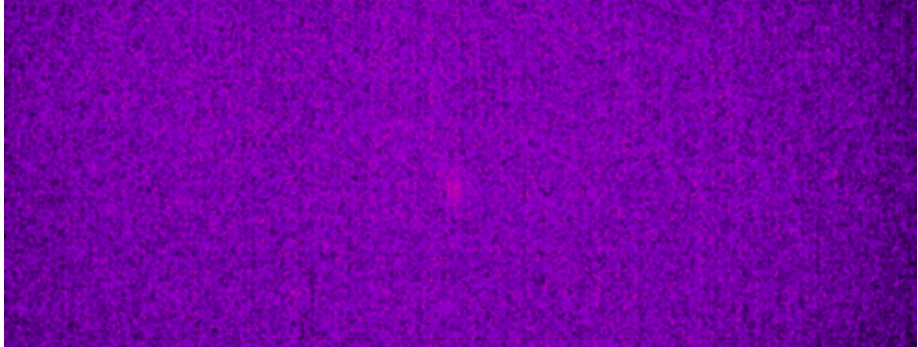
t = 0.649 s, Δ T = 0.16 ℃ (experiments)